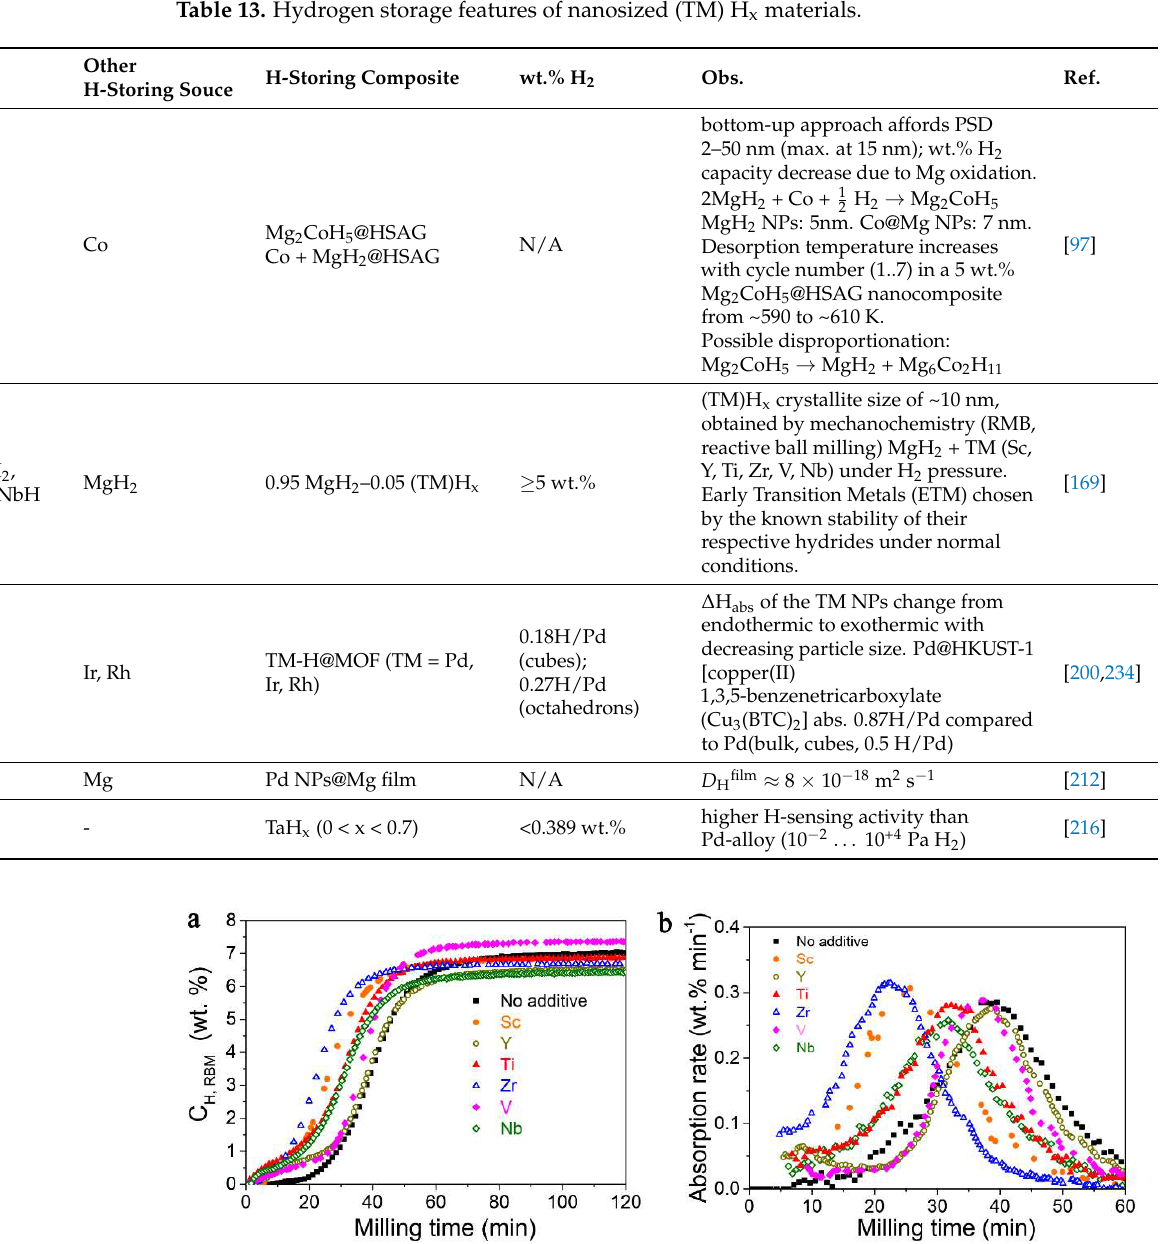
Table 13. Hydrogen storage features of nanosized (TM) H x materials.